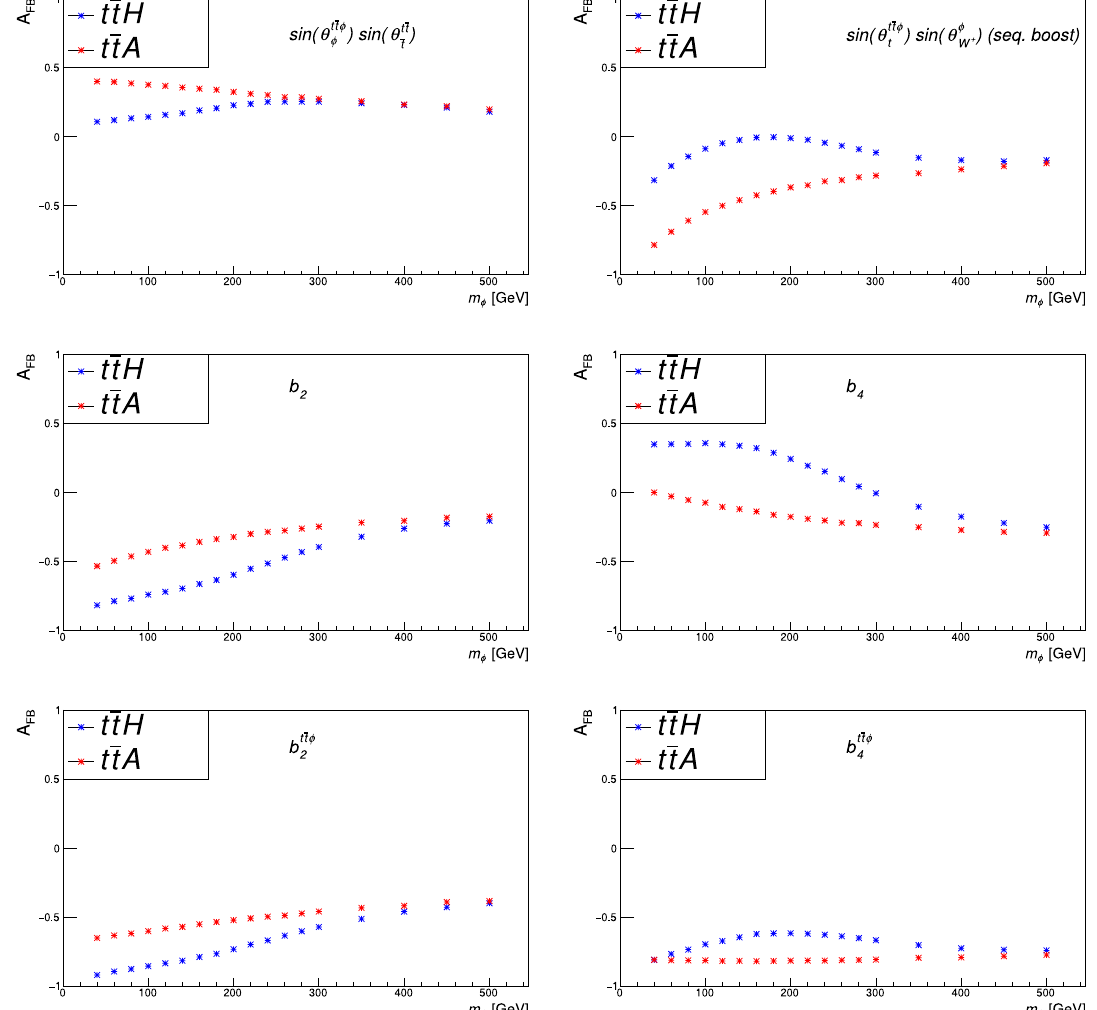
Figure 6. Forward-backward asymmetries as a function of the (cid:30) boson mass, without cuts, at NLO+Shower. On top, we have two angular distributions, sin (cid:18) t (cid:22) t(cid:30) sin (cid:18) t (cid:22) t(cid:30) sin (cid:18) (cid:30) with a sequential boost (right panel). On the middle and last rows, we show t W + the variables b 2 (left) and b 4 (right), in the LAB and centre-of-mass frames, respectively.